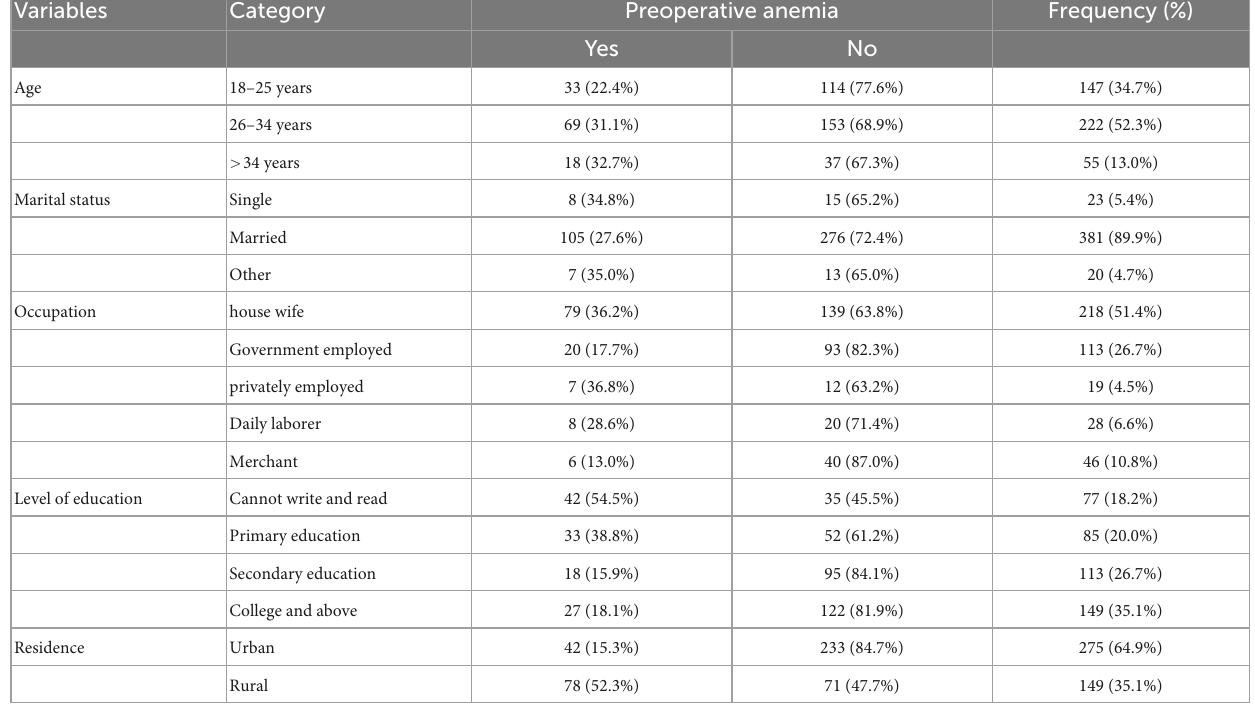
TABLE 1 Socio-demographic characteristics of women undergoing cesarean section at University of Gondar comprehensive specialized hospital, 2022.